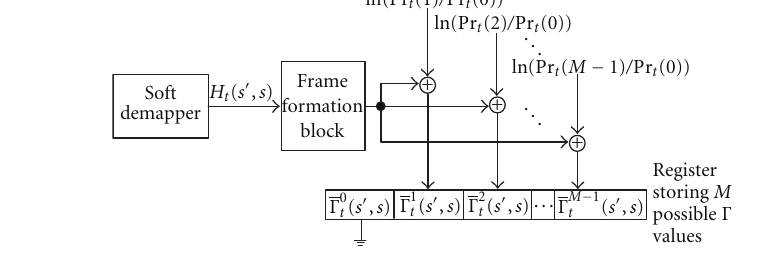
Figure 2: VLSI architecture of SISO-MAP decoder.